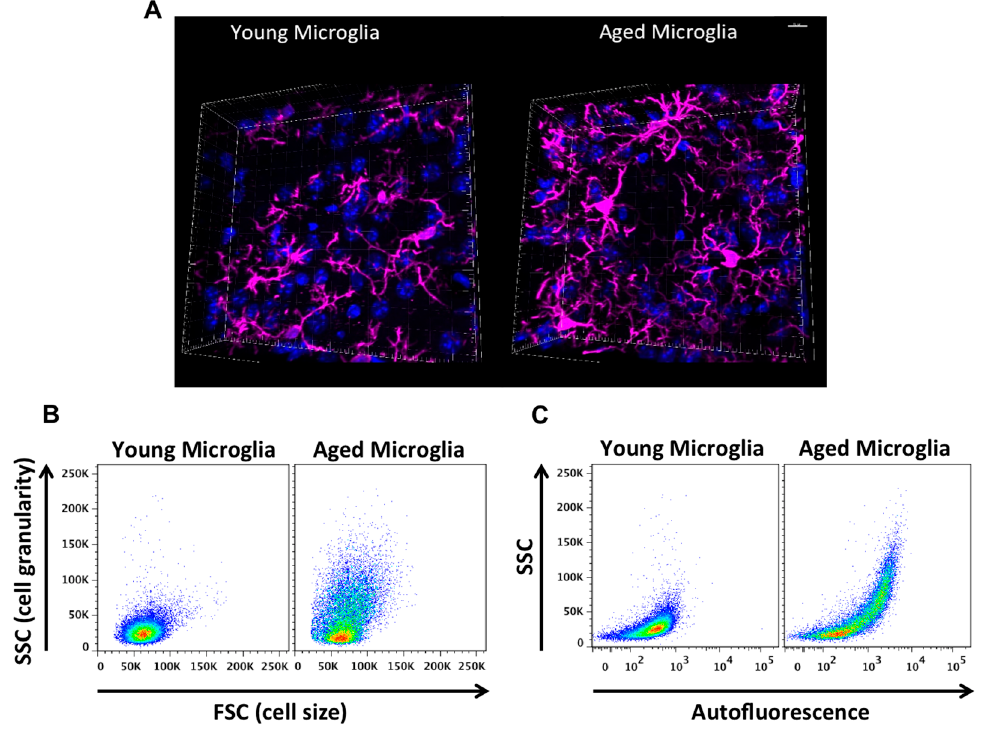
Figure 3. Age-related microglial dystrophy. Confocal microscopy images of DAPI-counterstained (blue) Iba1-positive cortical microglia (pink) highlight the enlarged soma and abnormal, twisted cytoplasmic processes of aged microglia ( A ); Flow cytometry preparation of CD45 int CD11b + Ly6C − microglia demonstrate a significant increase in cellular granularity and size with age ( B ). A population of side scatter-high aged microglia exhibits high levels of autofluorescence in the fluorescein isothiocyanate (FITC) channel compared to their younger counterparts and is indicative of lysosomal dysfunction ( C ).